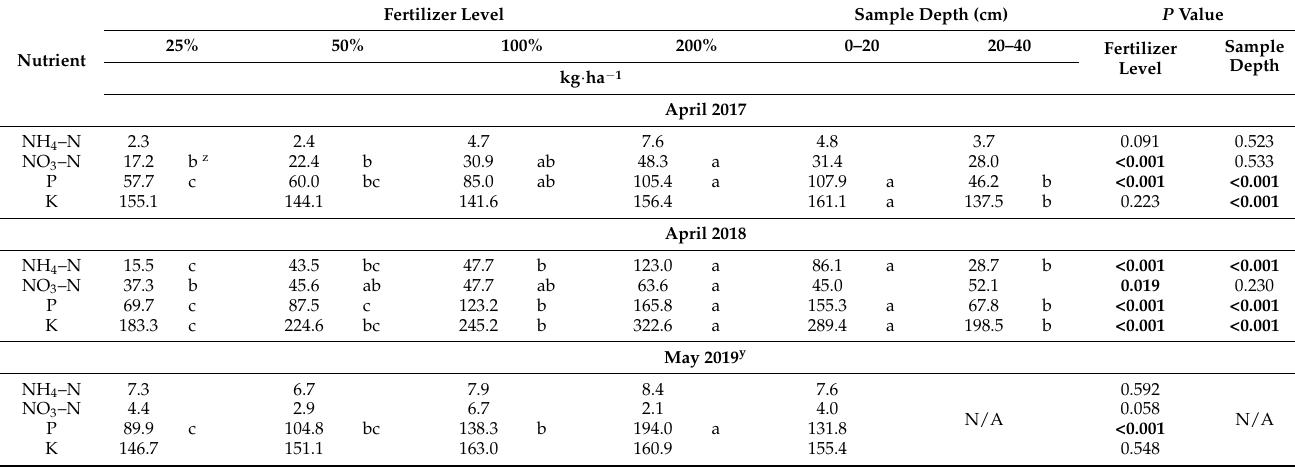
z Means followed by the same letter within a row and treatment effect (fertilizer levels or sample depth) are not significantly different by Tukey’s honestly significant different test, P ≤ 0.05. Means without letters indicate non-statistical differences, P > 0.05. y Samples were collected only from the 0–20 cm soil